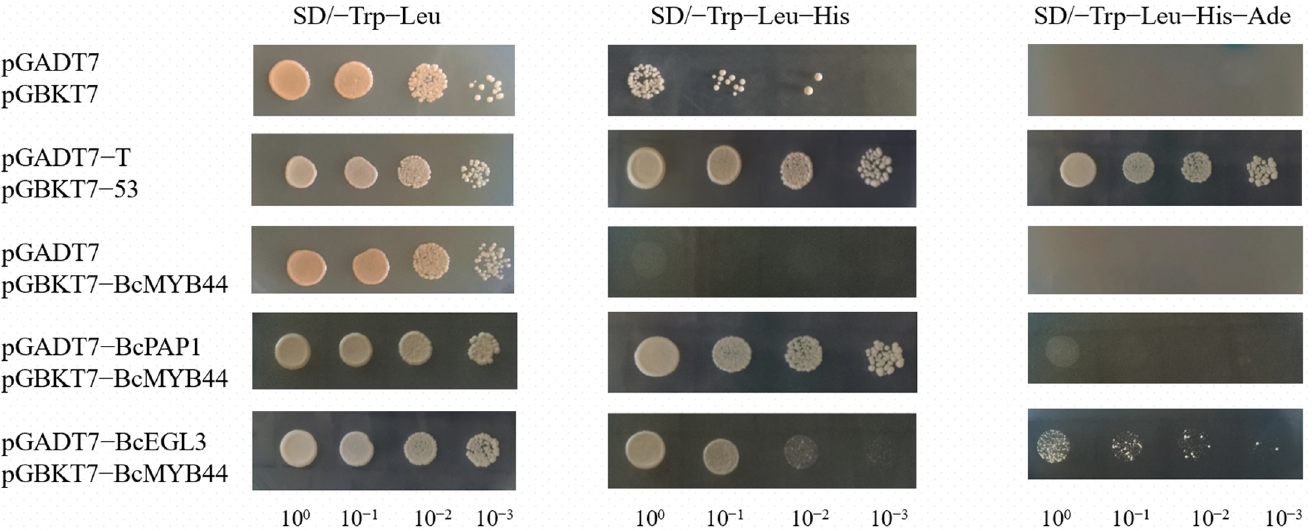
Figure 3. Y2H results of BcMYB44 and BcPAP1/BcEGL3, pGADT7 + pGBKT7 and pGADT7-T + pGBKT7-53 were the negative and positive control.